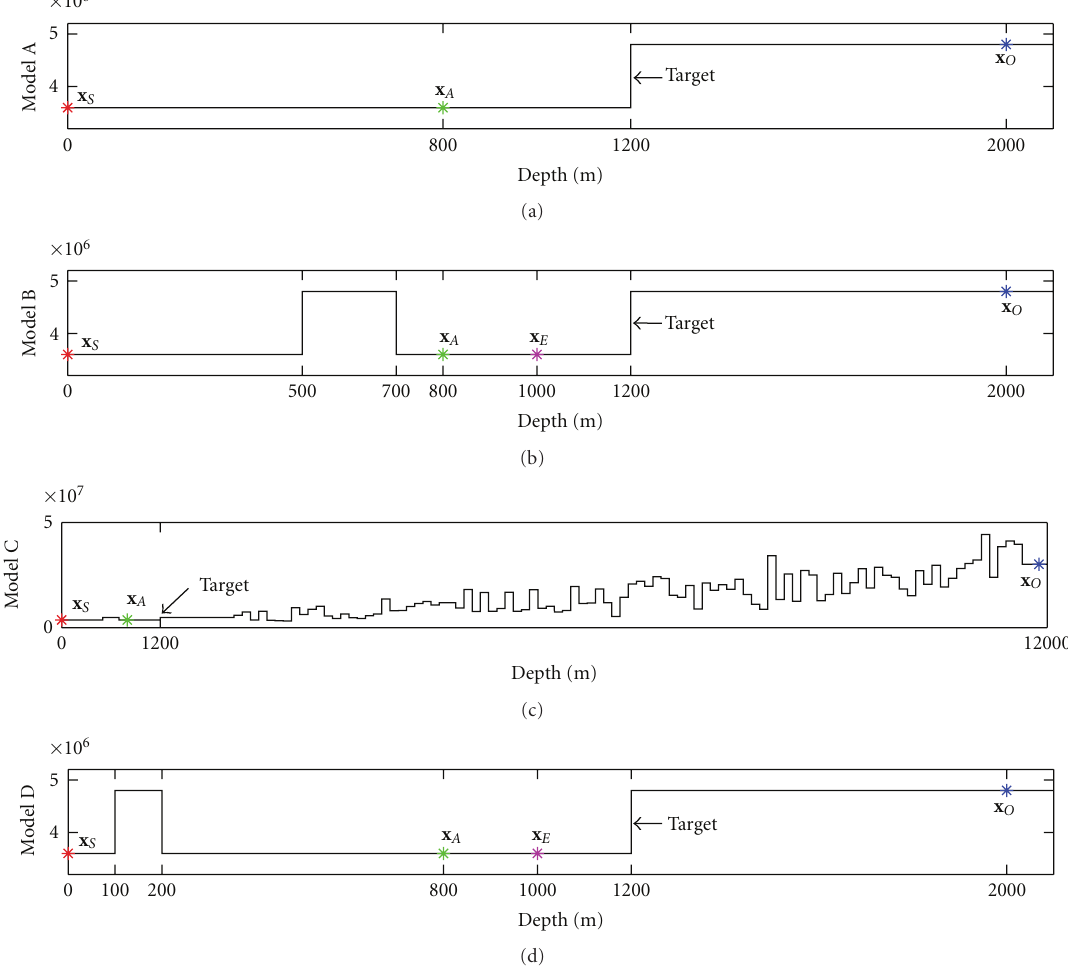
Figure 3: Impedance (in kg · m − 2 · s − 1 ) versus depth (in m) for synthetic models A–D. The red star corresponds to source location x S , the green star to receiver/virtual source location x A = x B , the blue star to nonexisting source location x O , and the magenta star to nonexisting source location x E ; models A–C have no free surface incorporated; model D has a free surface at 0m